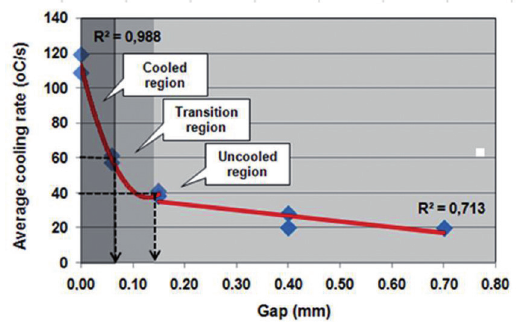
Figure 12: Effect of the gap size on the cooling rate showing different cooling conditions.